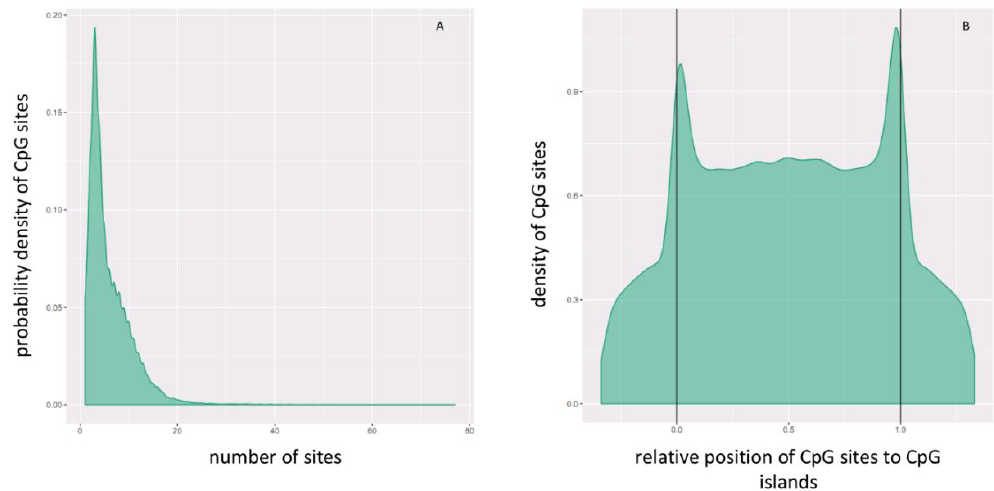
Figure 6. CgG site distribution ( A ) per and ( B ) across CpG islands. In panel B, the relative coordinates of 0 and 1 correspond to the start and end coordinates of each CpG island. Coordinates smaller than 0 and greater than 1 denote flanking regions normalized by region length. CpG sites are more dense at the start and end of CpG